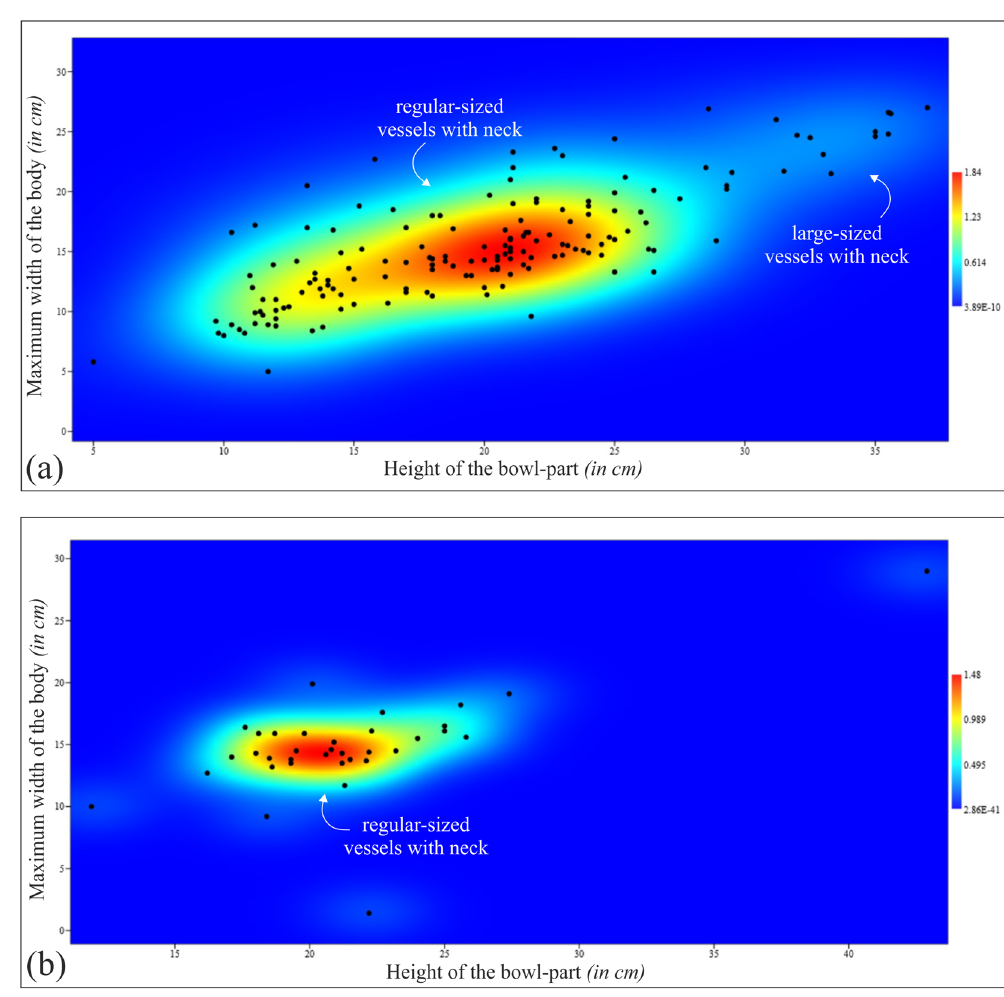
Figure 8: Kernel density plot of vessels with neck at: ( a ) Tiszapolgár - Basatanya and ( b ) Tiszavalk -